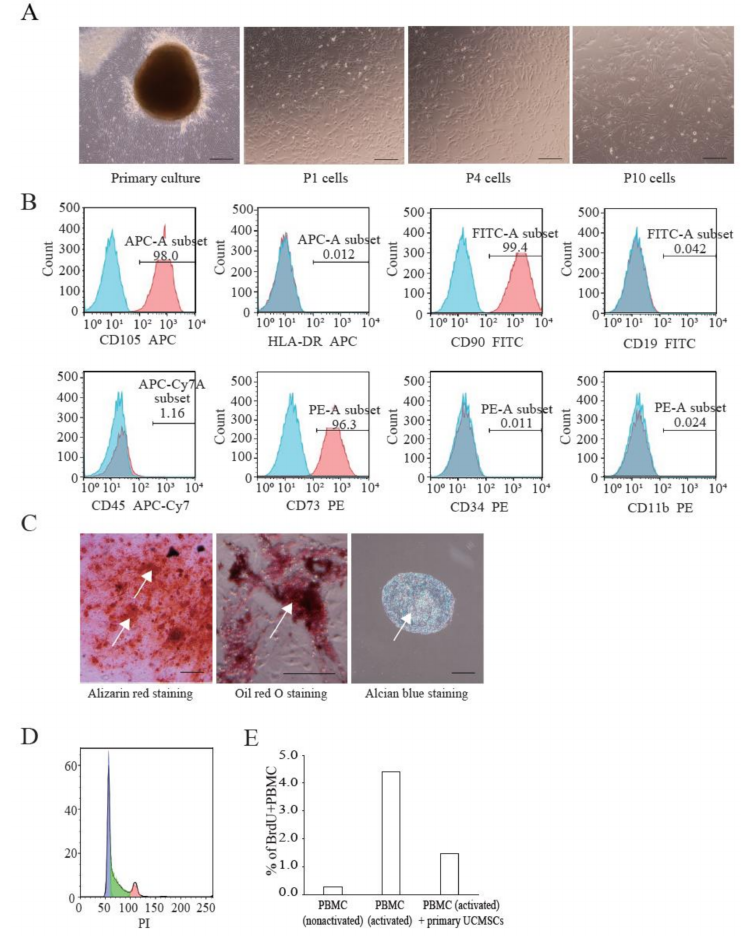
Figure 3. Characterization of UCMSCs from donors. ( A ) Culture and expansion of UCMSCs. Scale bar = 250 µ m. ( B ) Representative flow cytometry histograms of human UCMSCs. UCMSCs were positive for CD105, CD90, and CD73, and negative for CD11b, CD19, CD34, CD45, and HLA-DR. Blue histograms are isotype controls and red histograms are experimental samples. ( C ) UCMSCs were successfully differentiated into adipogenic cells, chondroblasts, and osteoblasts. White arrows indicate stained cells. Scale bar = 500 µ m. ( D ) Cell cycle analysis. ( E ) UCMSCs inhibit PBMC